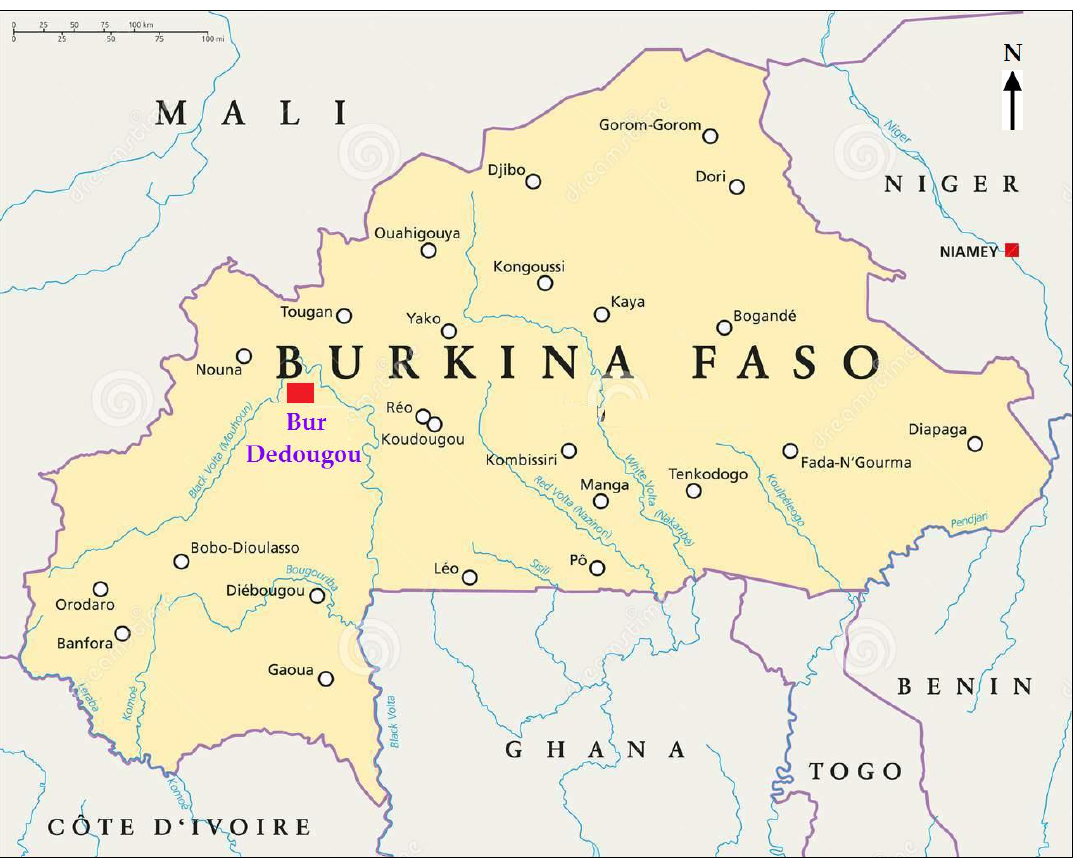
Figure 1. The location of the studied meteorological station Bur Dedougou in Burkina Faso, West Africa.